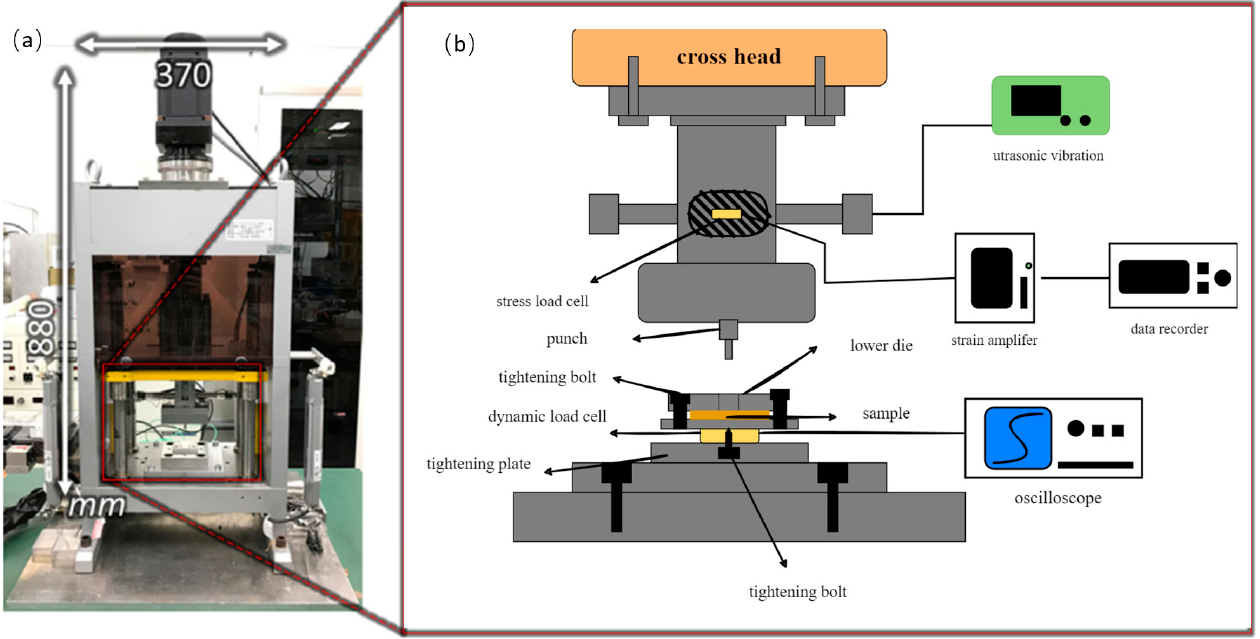
Figure 1. Configuration of the ultrasonic-assisted micro-forging system: ( a ) appearance of the desktop miniature servo press machine and schematic illustration of the micro-forging system. ( b ) Schematic illustration of the micro-forging system.